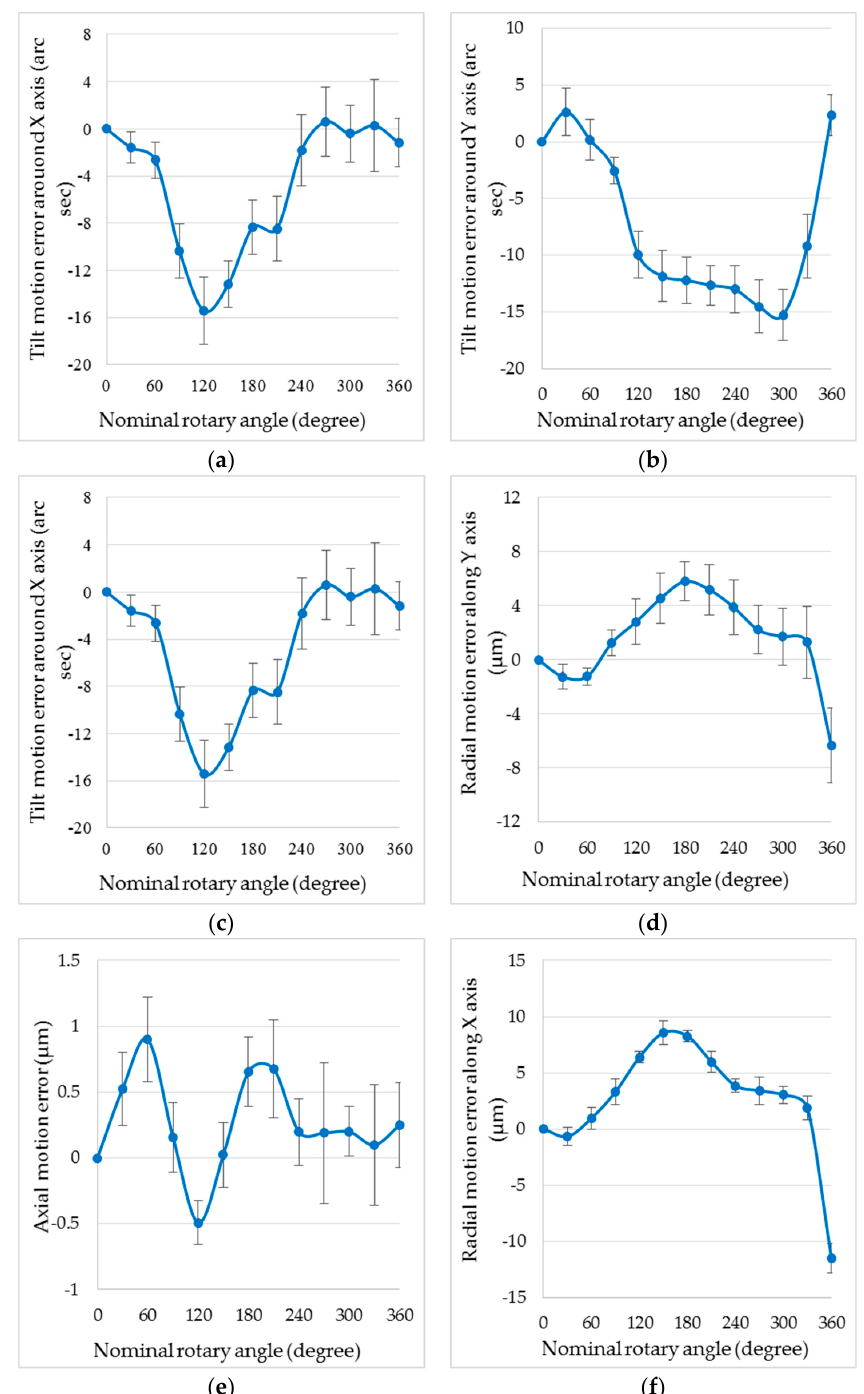
Figure 6. The repeatability of six DOF motion errors: the ( a ) angular positioning error, ( b ) tilt motion error around the y axis, ( c ) tilt motion error around the x axis, ( d ) radial motion error along the y axis, ( e ) axial motion error, and ( f ) radial motion error along the x axis.